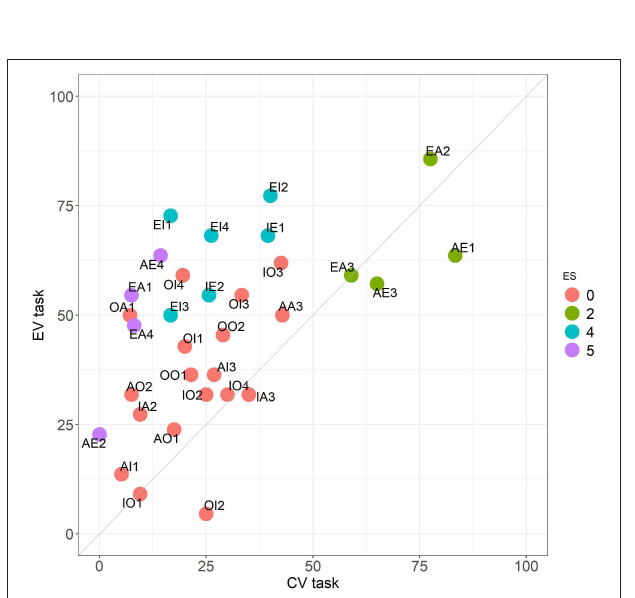
FIGURE 2 | Five tasks comparison in performance. Generation paradigm (left) and evaluation paradigm tasks (right).